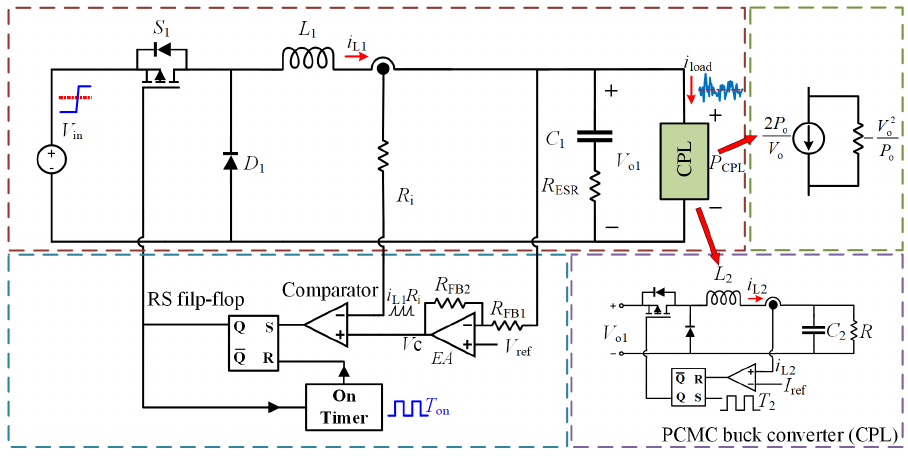
Figure 2. The prototype dual-stage cascaded dc